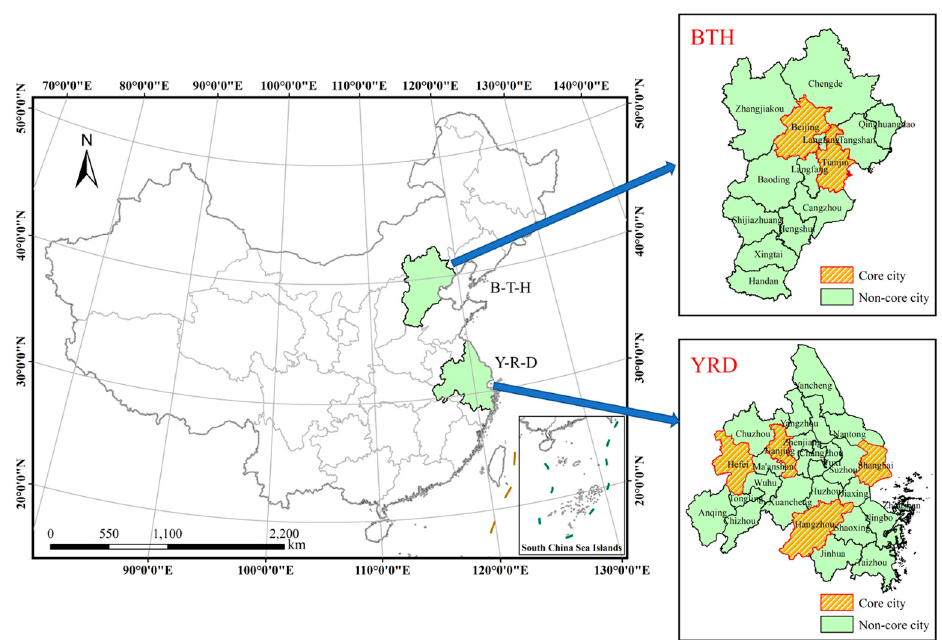
Figure 1. Spatial locations of Beijing–Tianjin–Hebei (BTH) and Yangtze River Delta (YRD) urban agglomerations in